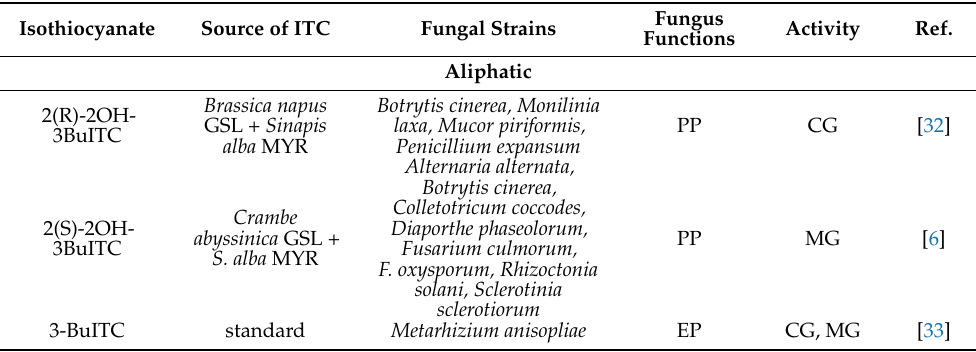
Table 1. A review of direct effects of purified, standard and synthesized (but naturally occurring) isothiocyanates in in vitro models using in-medium or vapor exposure. Reoccurring genus names in the same cells are